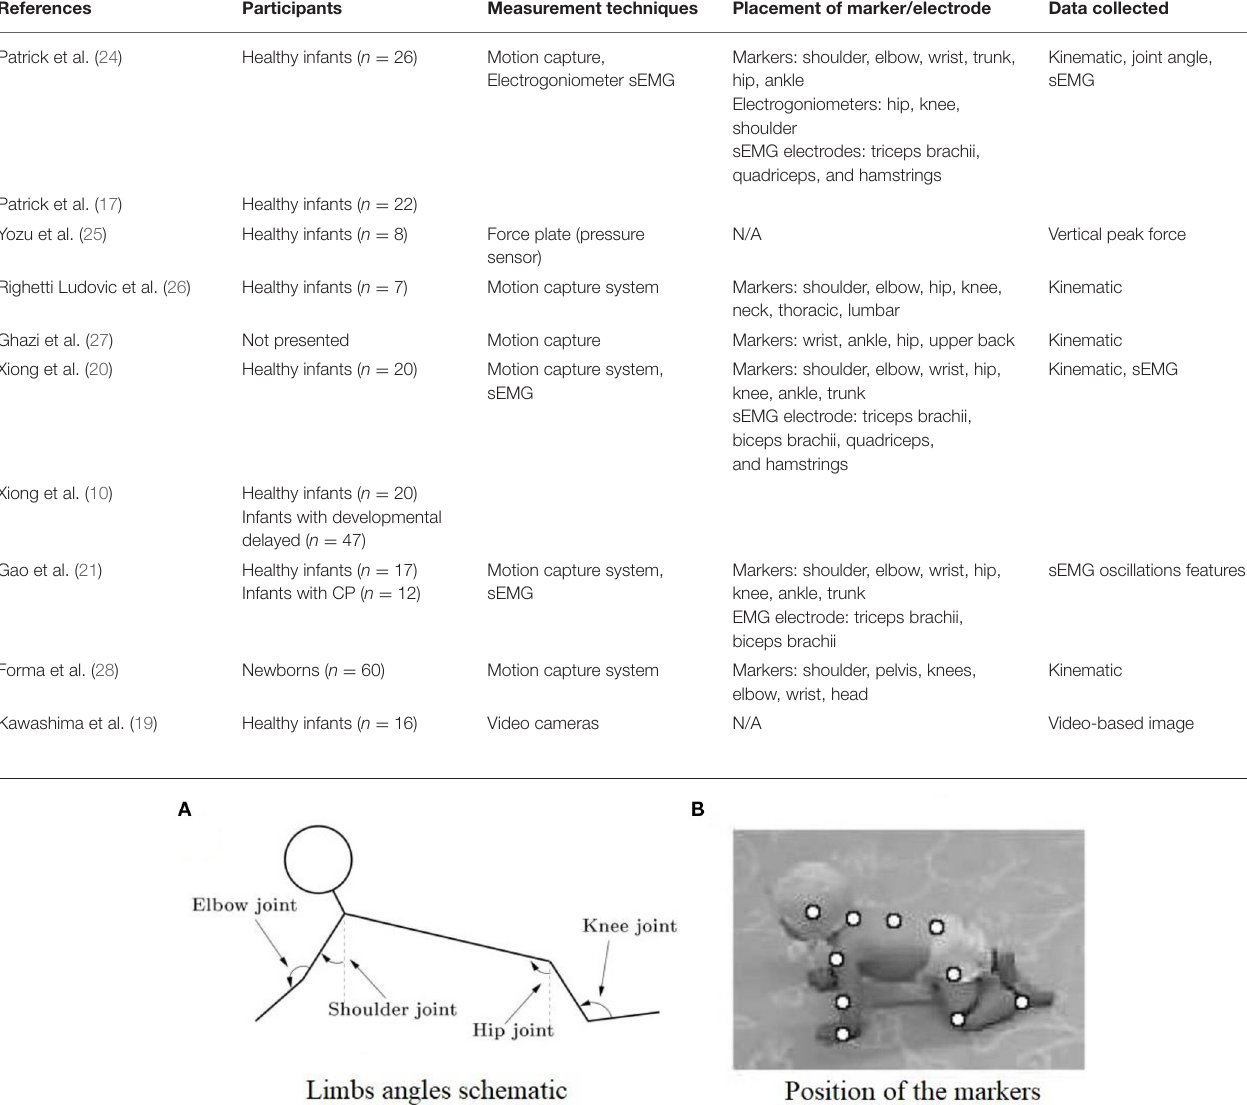
TABLE 1 | Overview of measurement techniques to monitor human infant crawling.